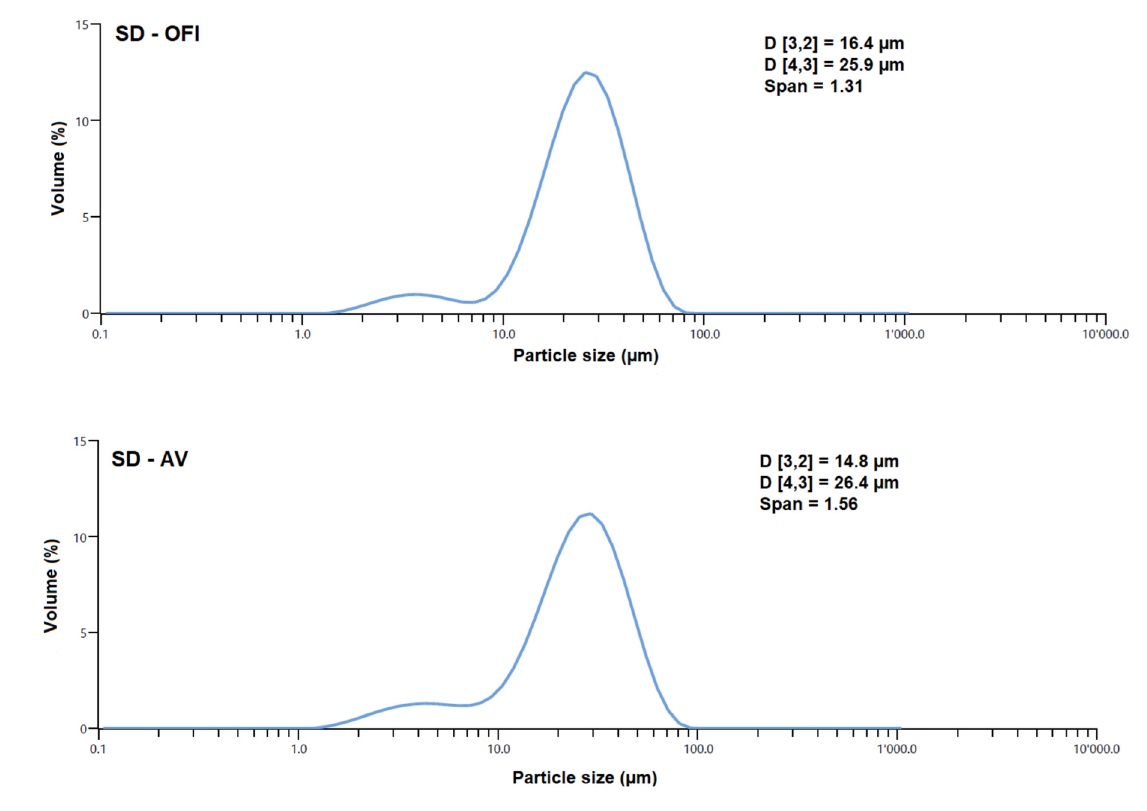
Figure 5. Particle size distribution plots of SD-OFI and SD-AV microcapsules. D[3,2] is area-volume mean diameter and D[4,3] is volume weighted mean diameter calculated by the software of the equipment used.